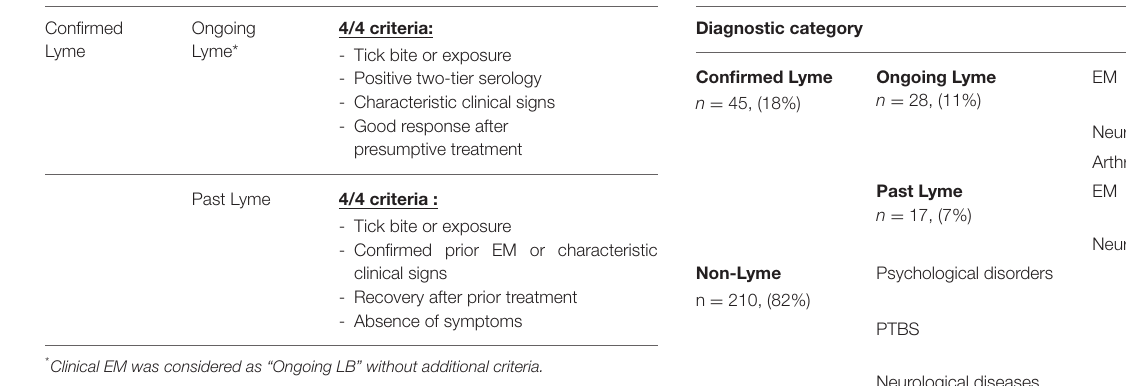
TABLE 2 | Lyme Borreliosis diagnostic